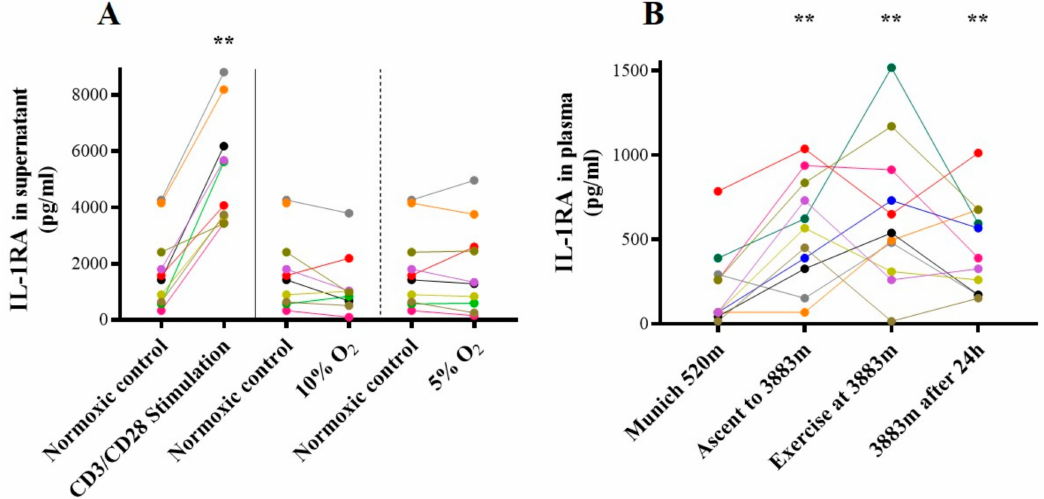
Figure 6. IL-1RA. Concentration of IL-1RA ( A ) in vitro in cell culture supernatant following inflammatory and hypoxic incubation, and ( B ) in vivo in plasma at different timepoints. ** p < 0.01 vs. baseline (Munich 520 m a.s.l. or normoxic control in vitro), IL-1RA = Interleukin-1 receptor